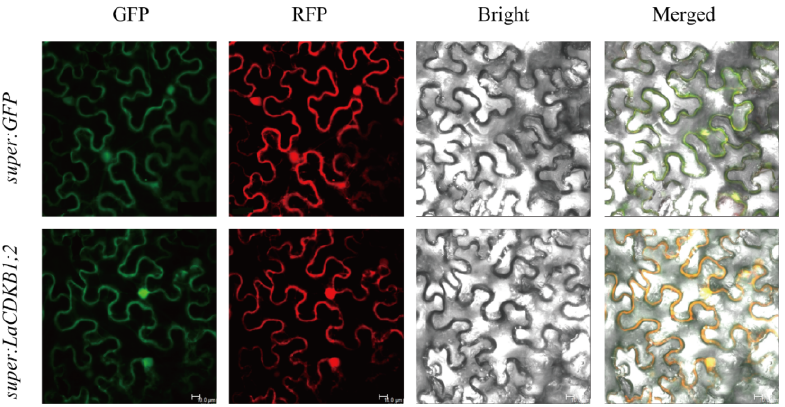
Figure 3. Subcellular localization of the LaCDKB1;2 protein. GFP: the distribution pattern of the LaCDKB1;2-GFP fusion protein; RFP: the distribution pattern of the AtPYR1-RFP fusion protein used as a positive marker; Bright: bright-field; Merged: merged image of LaCDKB1;2-GFP and bright-field. Scale bar: 10 µm.